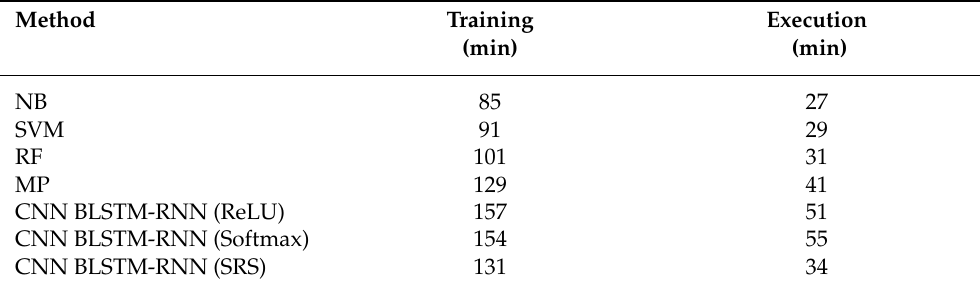
Table 1. Simulations time achieved by different methods and the proposed one for training and to execution time.